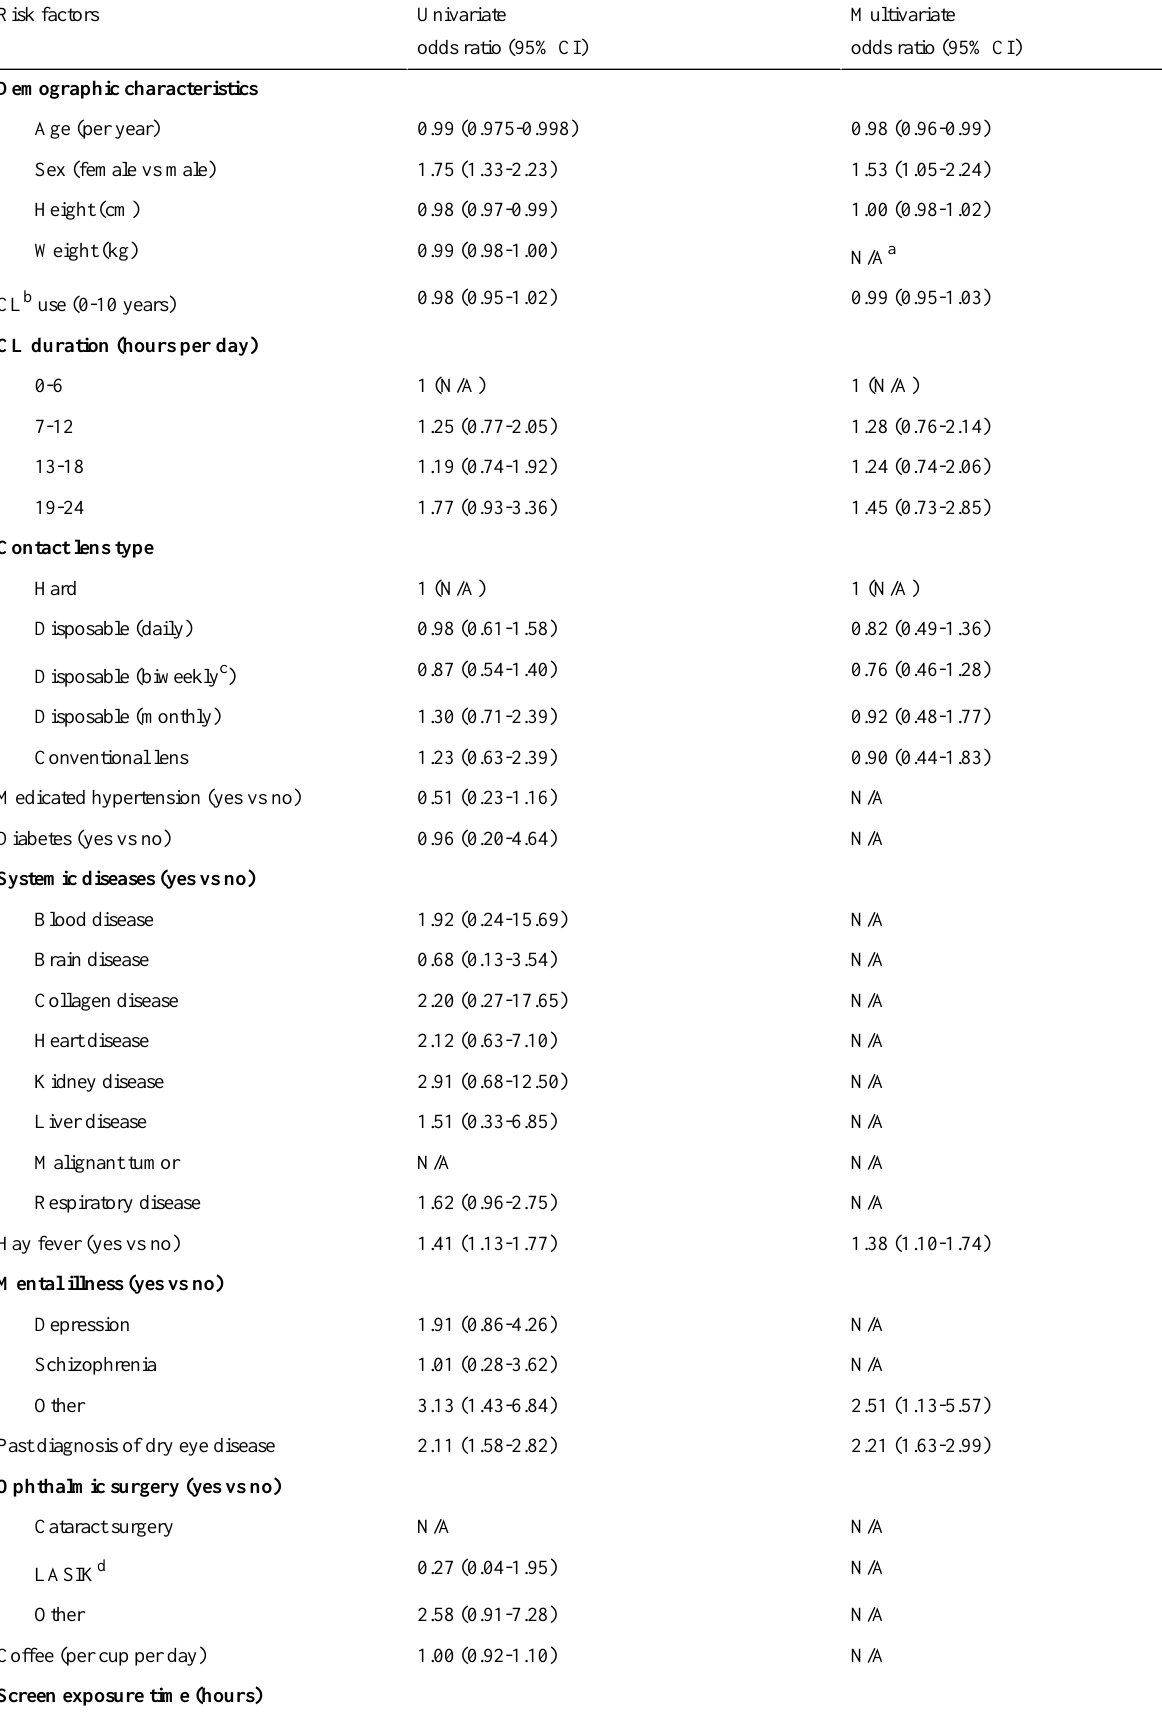
Table 2. Univariate and multivariate adjusted odds ratios of risk factors for contact lens–associated dry eye.